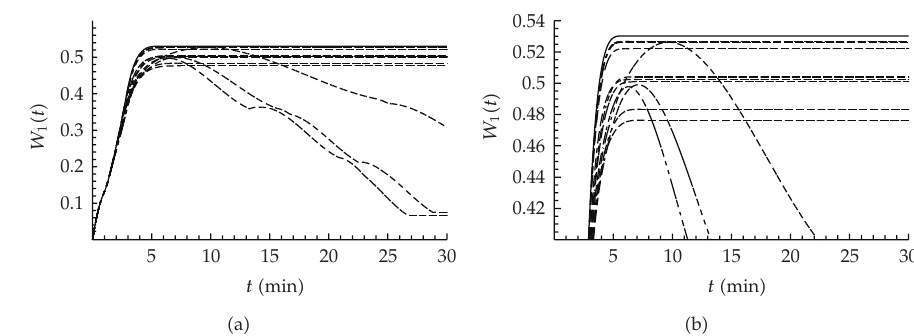
Figure 6: W 1 (cid:4) t (cid:7) evaluated for optimal distribution coe ffi cients (cid:4) continuous line (cid:7) and random choices (cid:4) dashed lines (cid:7) . (cid:4) a (cid:7) evolution in (cid:5) 0; T (cid:6) . (cid:4) b (cid:7) zoom around the asymptotic optimal values.